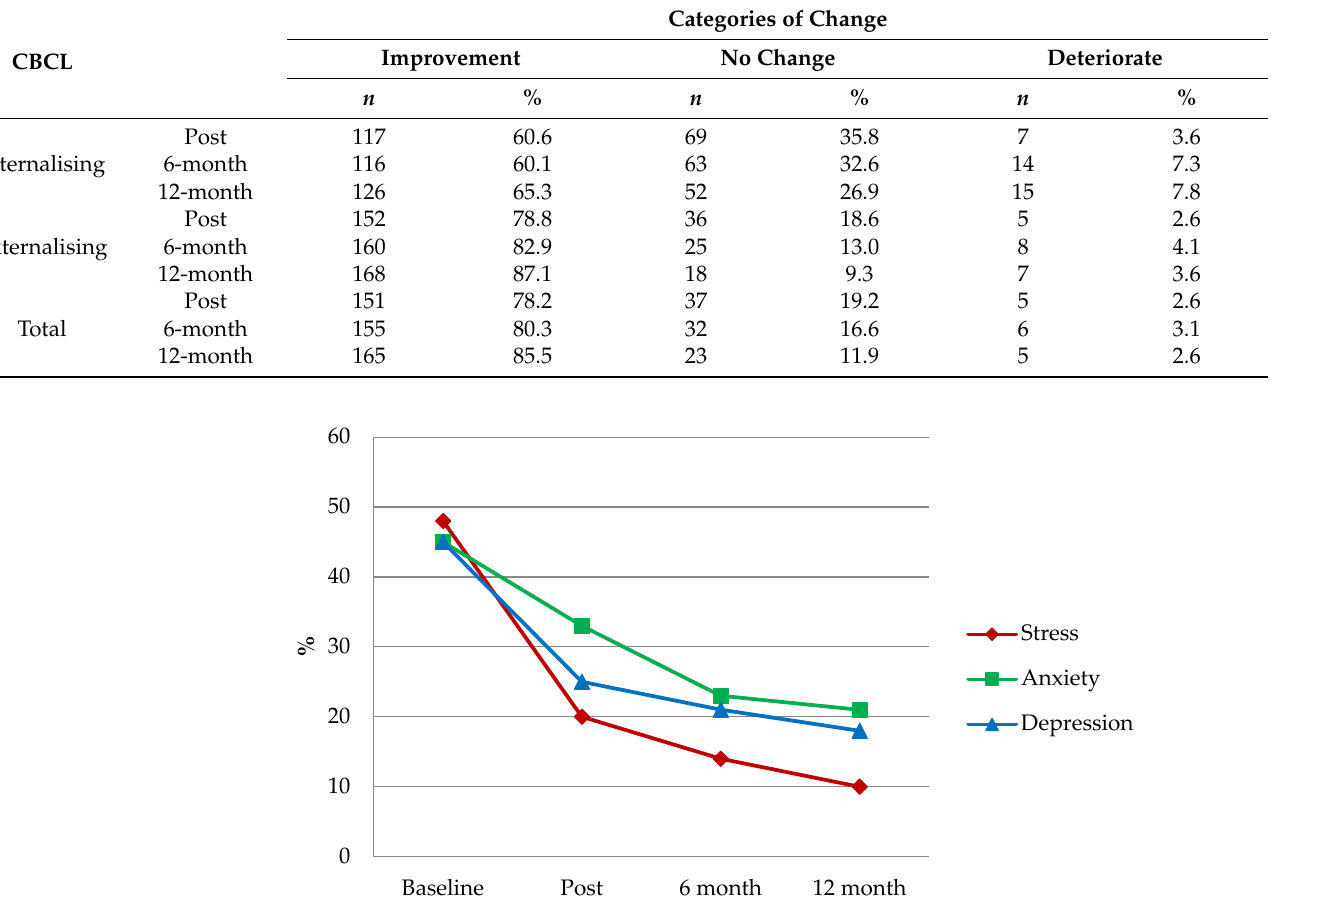
Table 1. % of adolescents in different categories of change from baseline in CBCL at post-treatment, 6- and 12- month follow-up ( n = 193).